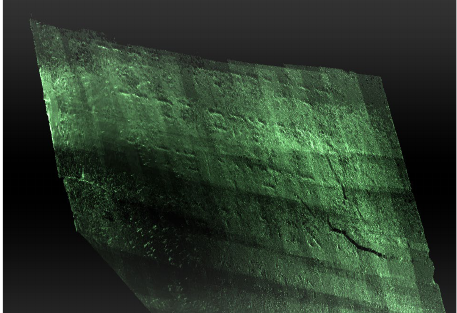
Figure 5. Pointcloud (Artec Spider) before processing.